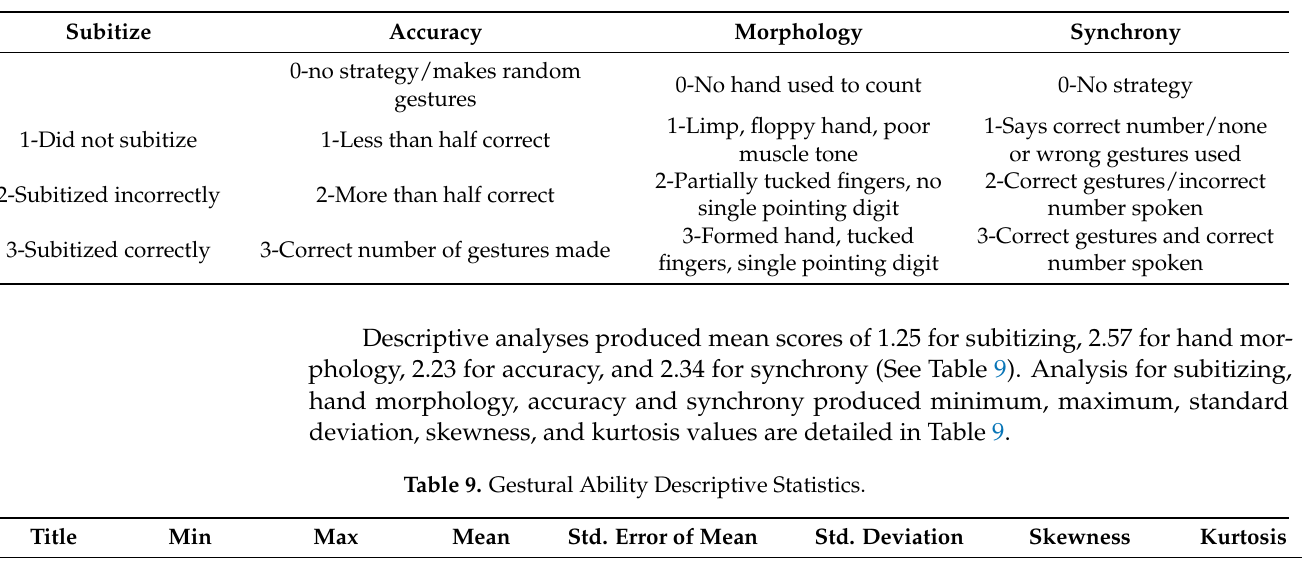
Table 8. Gesture Scoring System.